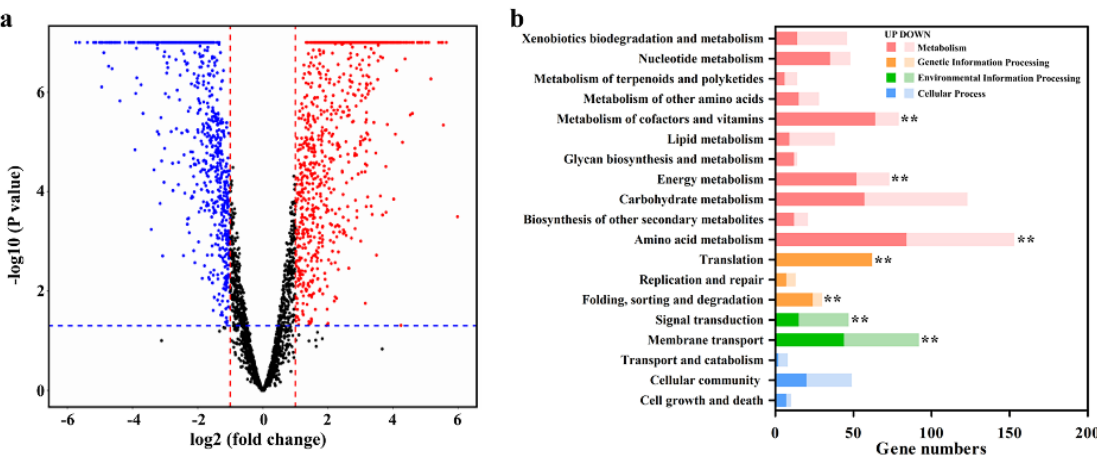
Figure 4. Volcano plot ( a ) and KEGG enrichment analysis ( b ) of DEGs from strain ZM05 with or without Cd(II) stress. ** p < 0.01.